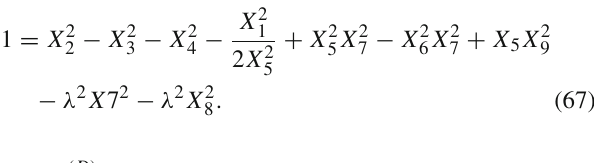
, (cid:12) η and (cid:12) ρ , m 0 1